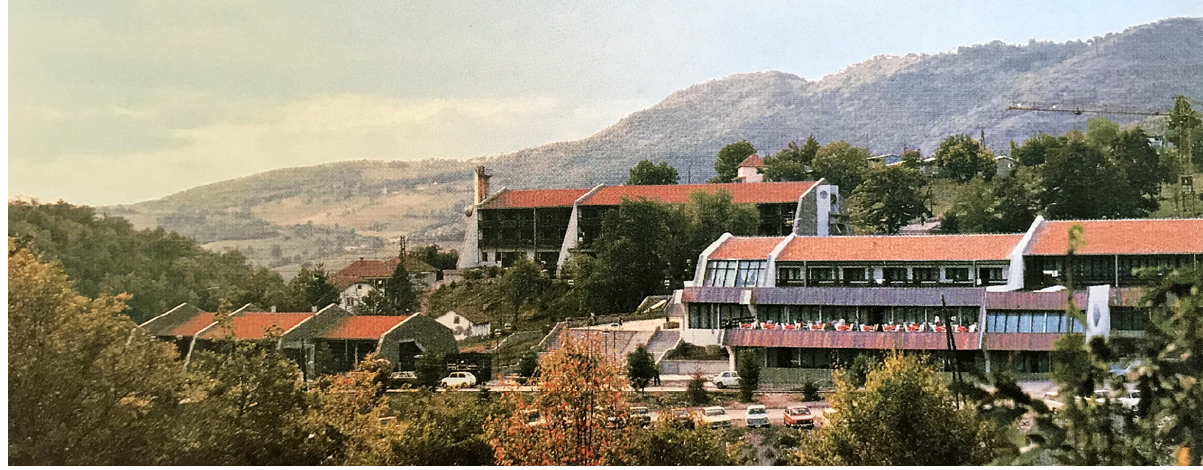
Franc Avbelj et al., Hotel Radan in Prolom Spa (1968) (Source: Private archive of Đ. Eraković in Kuršumlija,